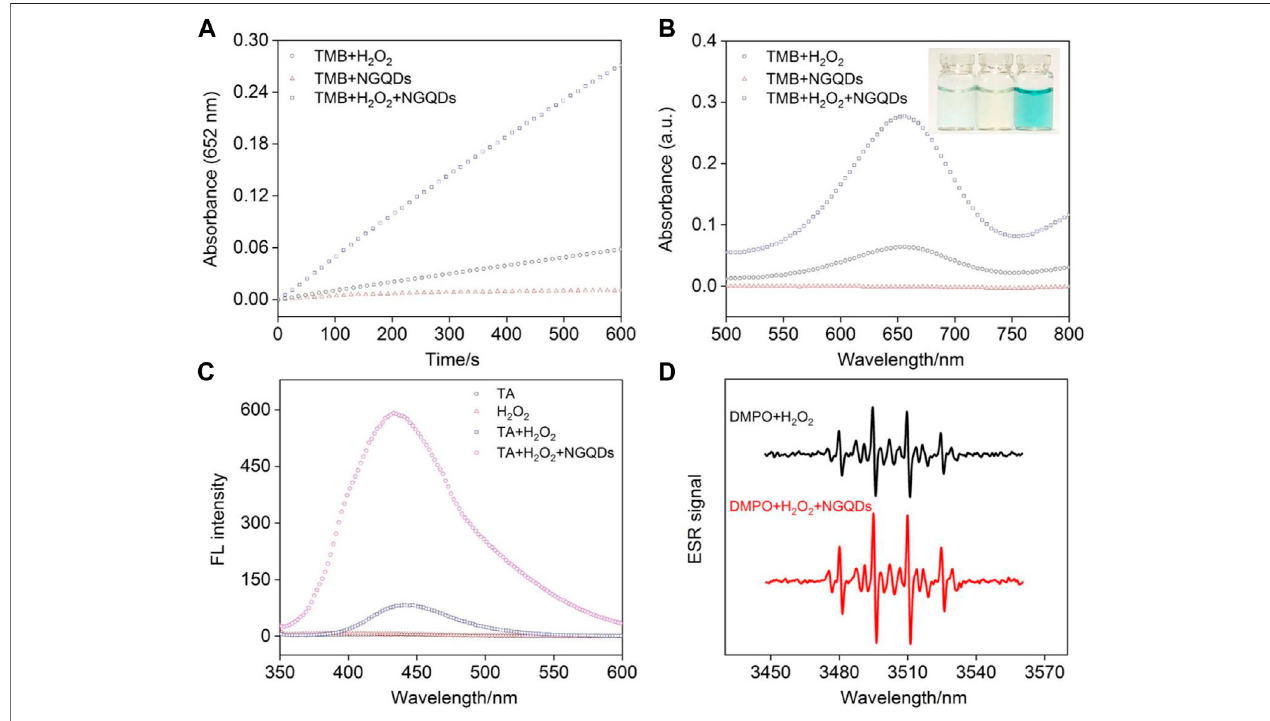
FIGURE 4 | (A) Time-dependent change of absorbance at 652 nm and (B) absorbance spectra of different mixture solutions of NGQDs, H 2 O 2 , and TMB after 10 min reaction. Inset in b are photographs of TMB solution in the presence of NGQDs (left) , H 2 O 2 (middle) , and NGQDs + H 2 O 2 (left) . (C) Fluorescence spectra obtained in TA, H 2 O 2 , TA + H 2 O 2 , and TA + H 2 O 2 +NGQDs solutions. (D) EPR spectra obtained in the mixture of DMPO and H 2 O 2 in absence or presence of